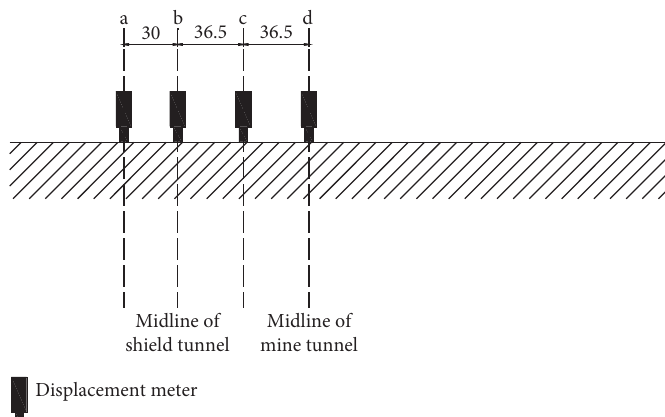
Figure 10: Layout of monitoring points for surface subsidence (unit: cm).